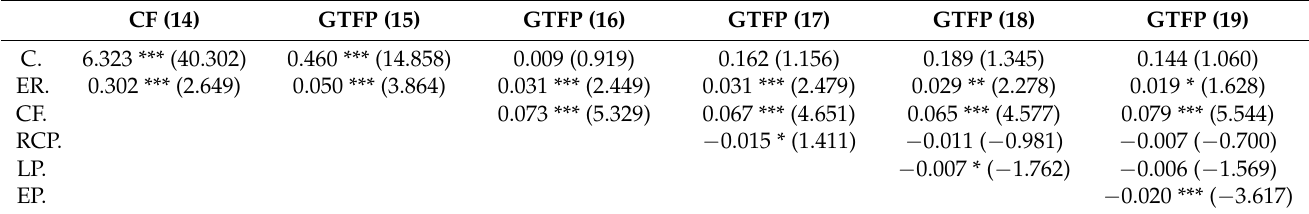
Table 5. Benchmark regression results.